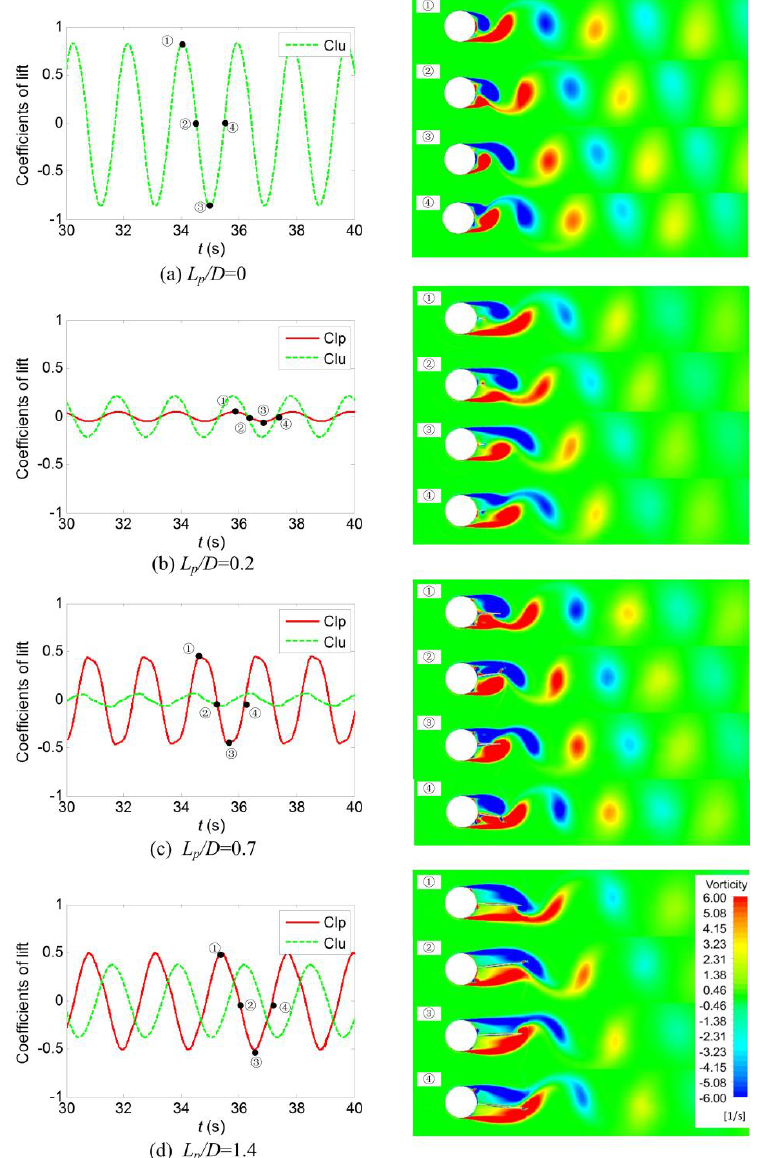
Figure 16. Wake structures for different plate lengths: ( a ) L p / D = 0, ( b ) L p / D = 0.2, ( c ) L p / D = 0.7, and ( d ) L p / D = 1.4.